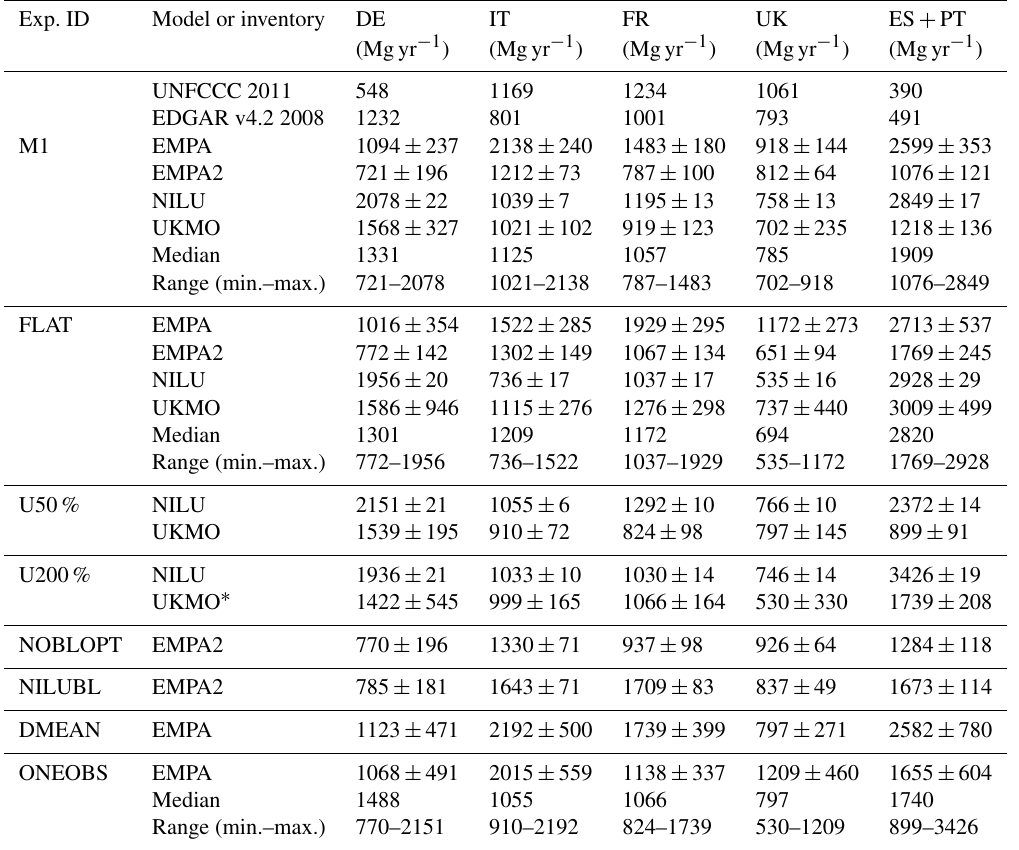
Table 3. Emissions of HFC-125 in the main experiment M1 and the different sensitivity experiments for major countries in western Europe. UNFCCC refers to the 2011 emissions according to the country reports submitted to UNFCCC in 2013. EDGAR v4.2 refers to 2008 emissions according to the gridding method applied by EMPA2. Uncertainties are shown as ± 1 σ